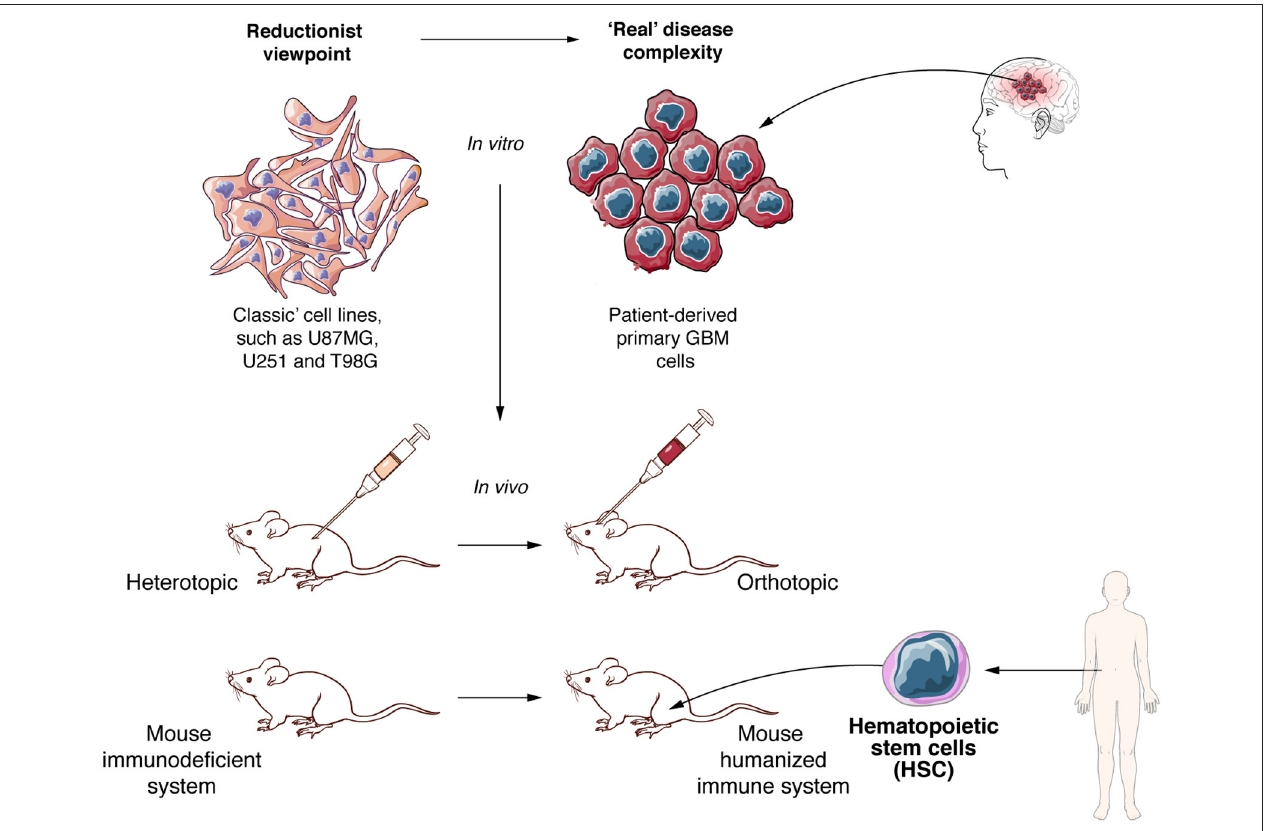
FIGURE 4 | To develop new and effective anti-GBM therapies better experimental models are required. Experimental in vitro and in vivo models need to move to more realistic settings. Patient derived primary cell lines and xenograft models, orthotopic tumor growth and mice with humanized immune system must become the standard to evaluate allogeneic CAR T cells against